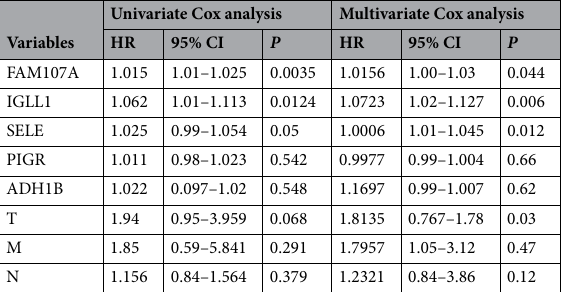
Table 4. Cox proportional hazards model analysis of prognostic factors.